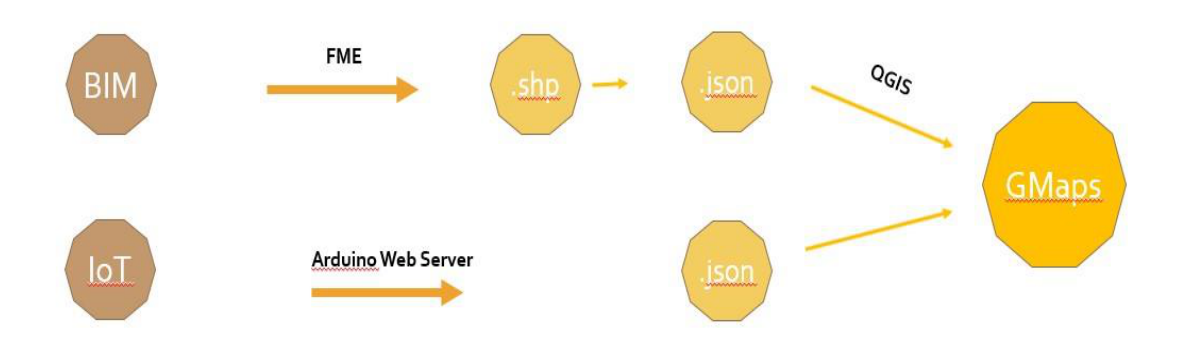
Figure 3. Integration